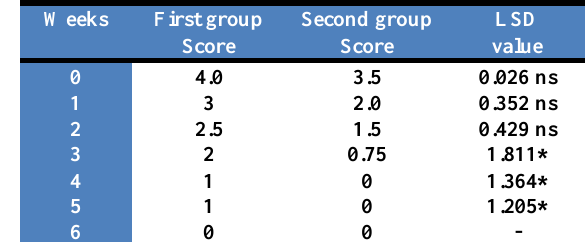
Table, 1: Shows the mean values of lameness scores of first and second